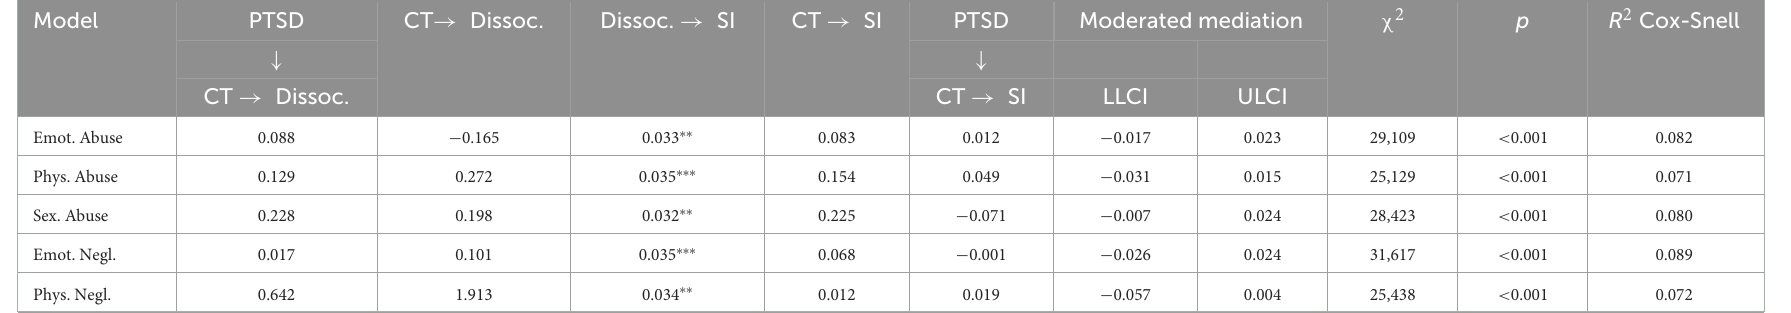
TABLE 2 Analysis of moderated mediation in the relationship between early childhood trauma and suicidal ideation. Model PTSD CT → Dissoc. ↓ ↓ CT → Dissoc.